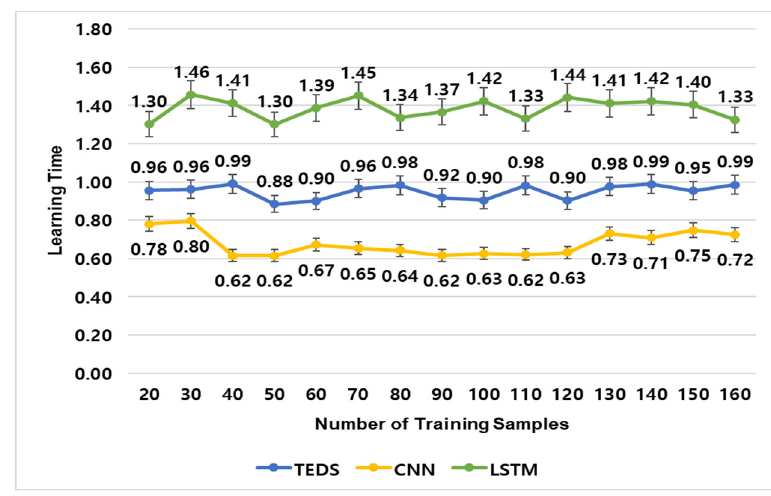
Figure 18. Graph of the learning time according to the training samples. CNN: convolutional neural network; LSTM: the long short-term memory models.